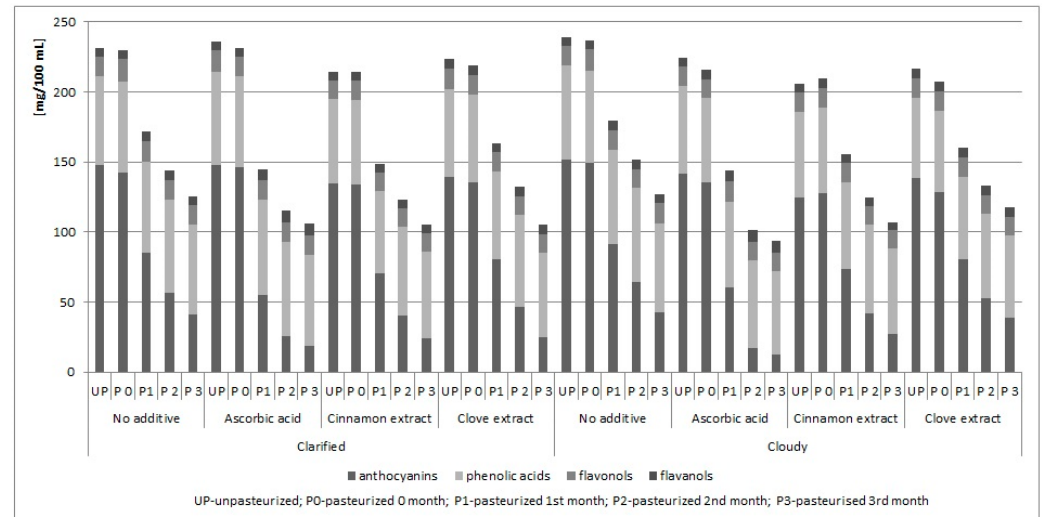
Figure 1. Changes in the content of individual groups of polyphenols in the analysed juices / drinks during storage.